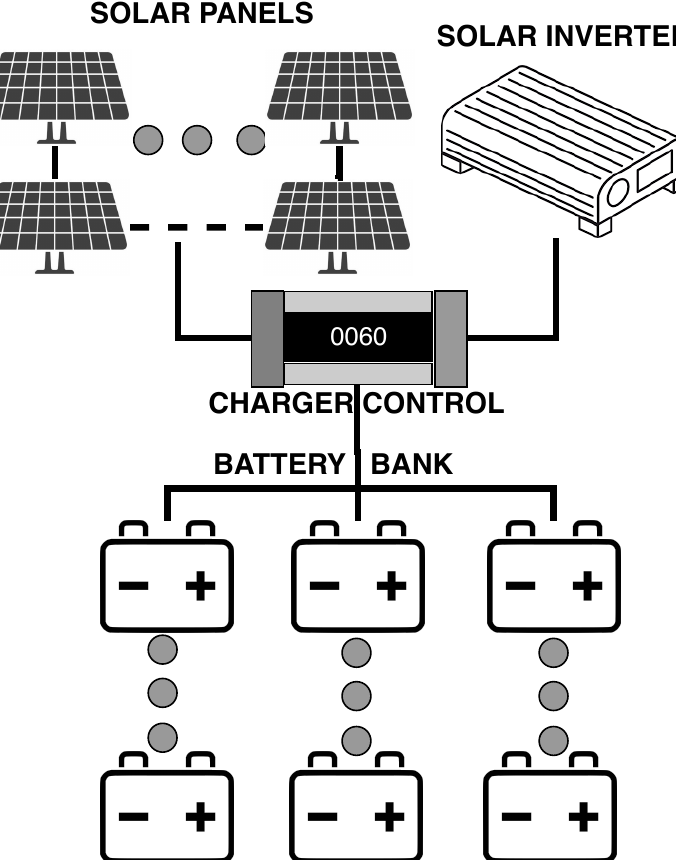
Figure 3. Hybrid photovoltaic system main